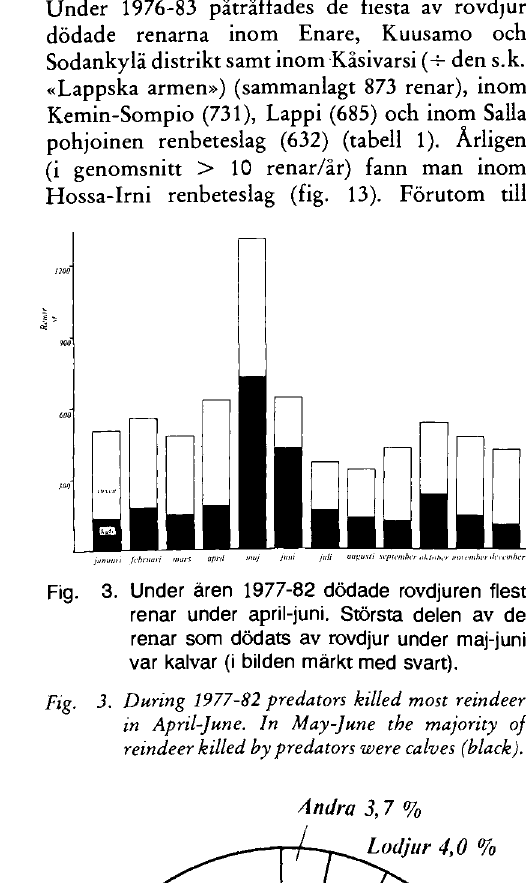
Fig. 5. Under åren